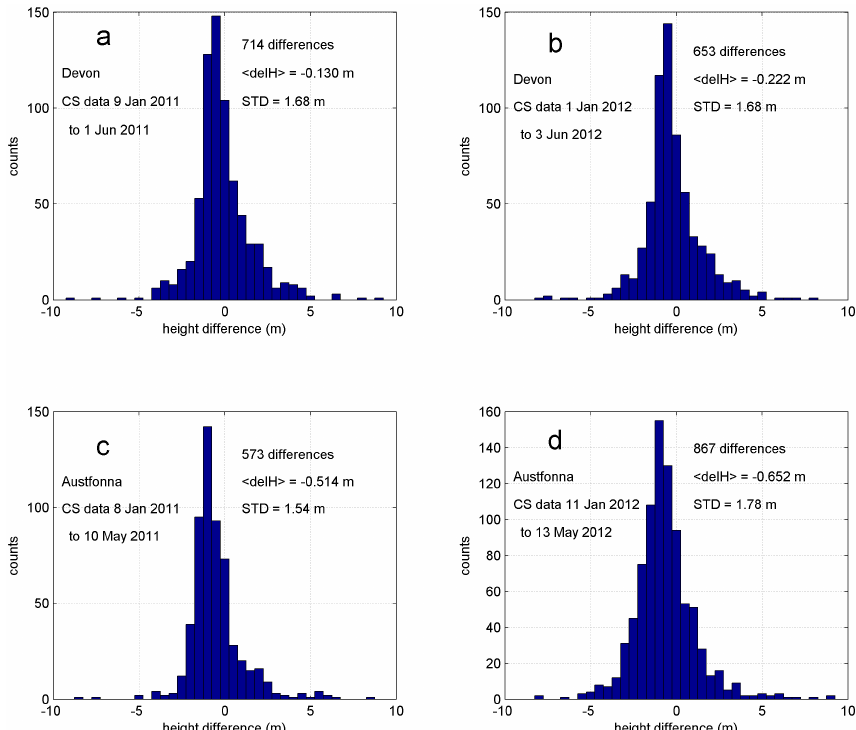
Figure 4. Histograms of the height differences, CS2 minus the reference elevations, acquired for Devon ( a 2011, and b 2012) and Austfonna ( c 2011 and d 2012). In the figures < delH > is the mean CS2 – reference